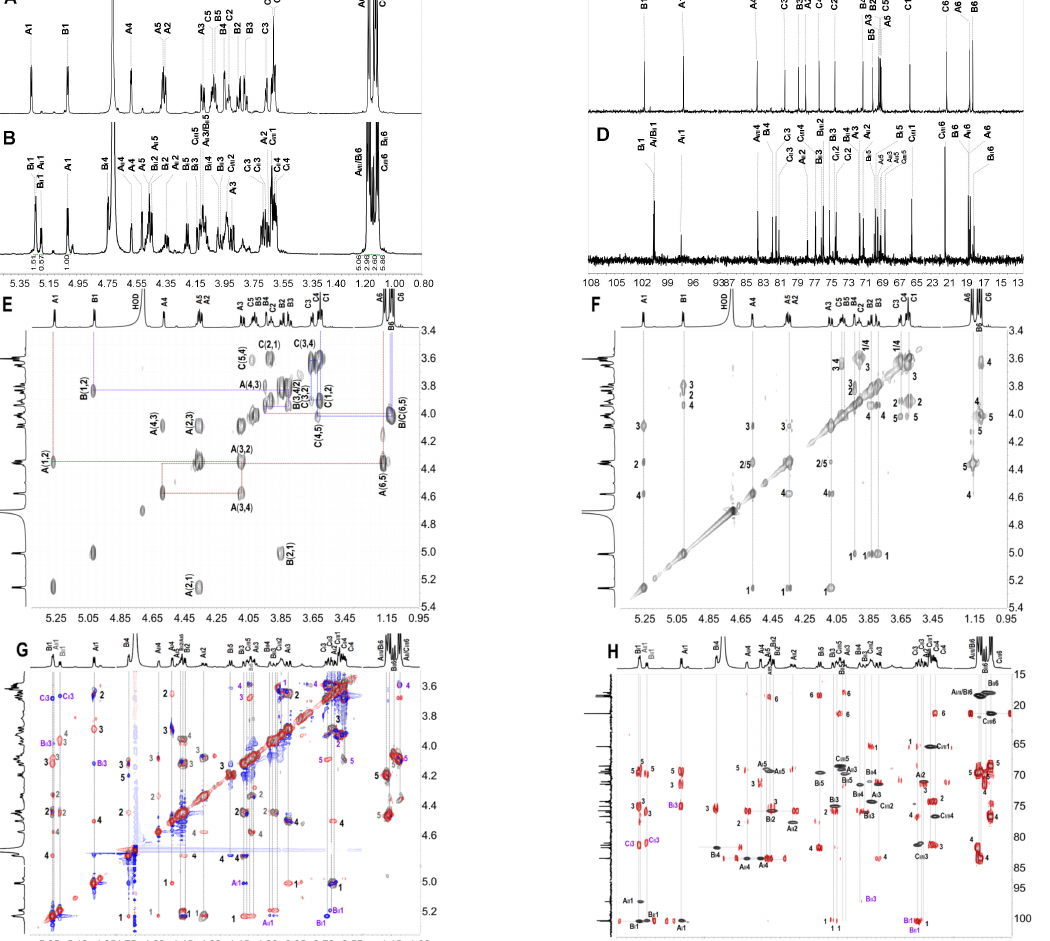
Figure 3. The 1 H ( A , B ) and 13 C ( C , D ) spectra of FIII and FIV, 1 H– 1 H COSY ( E ) and ROESY ( F ) of FIII; the overlapped 1 H– 1 H COSY (gray), TOCSY (red) and ROESY (blue) spectra ( G ) of FIV; and the overlapped 1 H- 13 C HSQC (gray) and 1 H- 13 C HMBC (red) spectra ( H